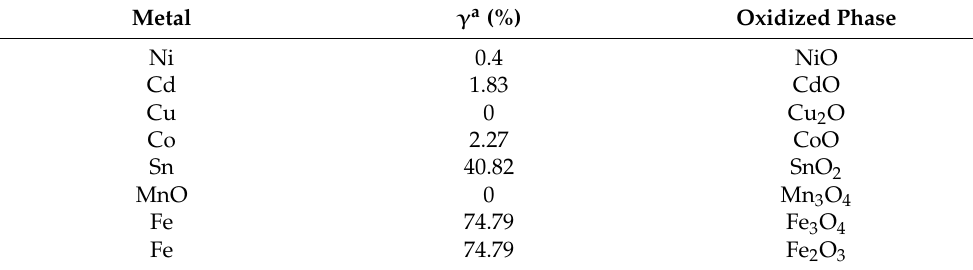
Table 1. The highest conversion rate ( γ a ) of water to hydrogen per pass at 600 °C [189].